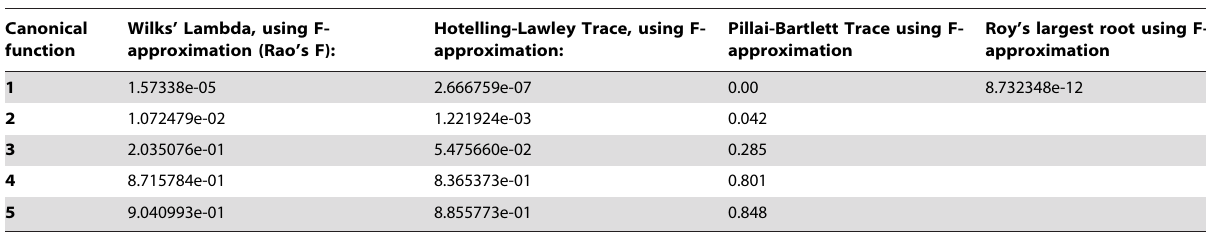
Table 4. Multivariate tests of significance for the canonical functions.